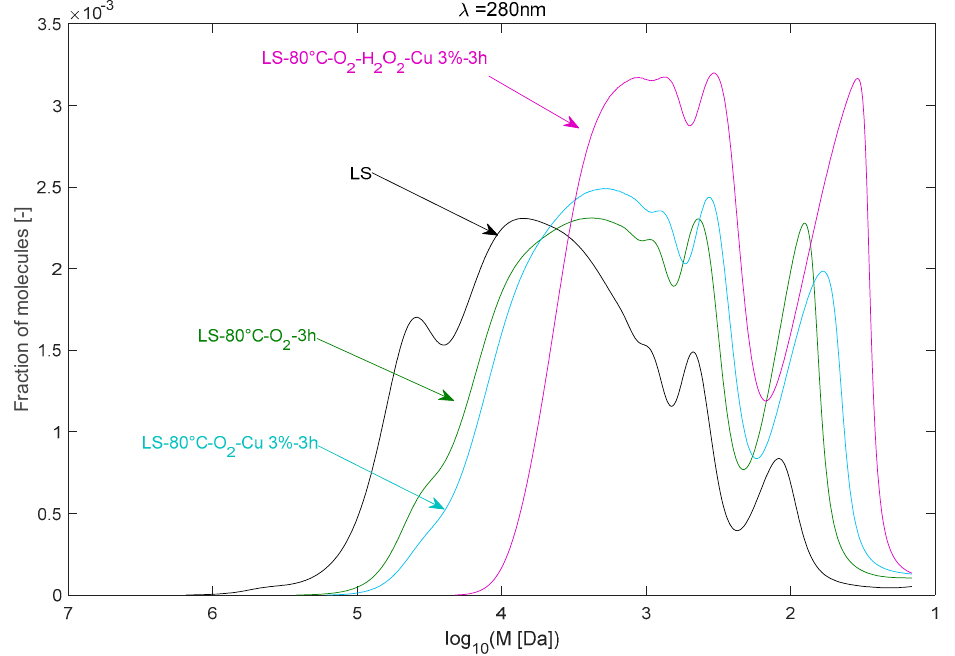
Figure 8. Effect of Cu 2+ on the molecular weight distribution of LS during the depolymerisation under O 2 and O 2 + H 2 O 2 .